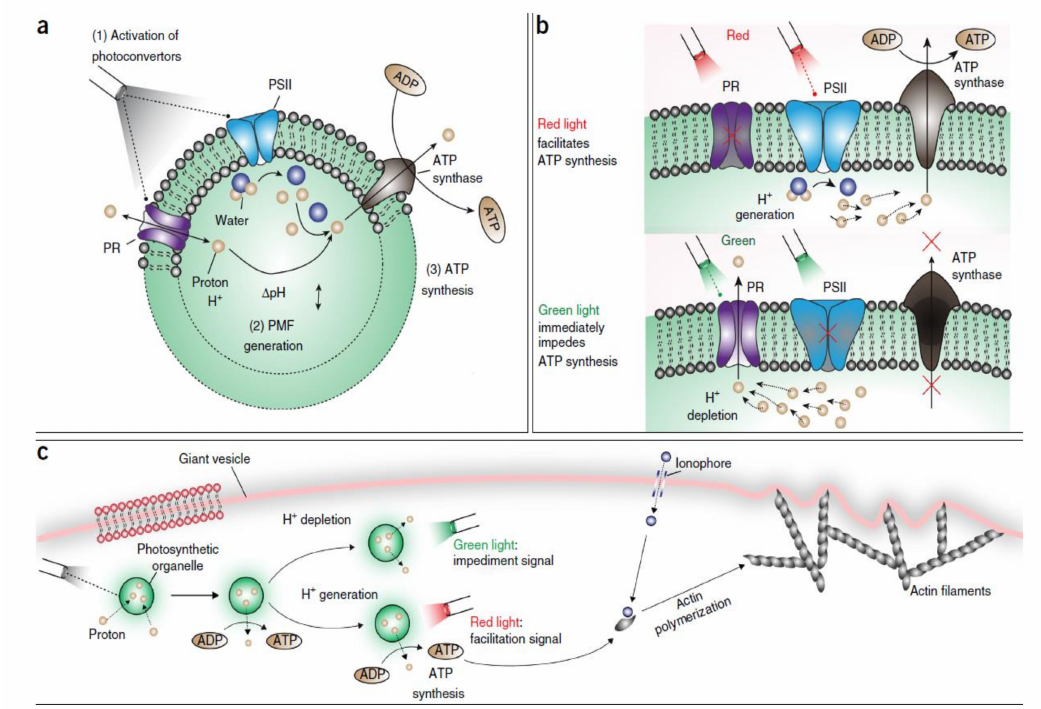
Figure 12. Artificial photosynthetic organelles and their application. ( a ) Via light activation, photosynthetic system II (PSII) and proteorhodopsin (PR) created a proton gradient and ATP was produced. ( b ) With the same photosynthetic organelle, ATP synthesis was controlled by an optical switch. Red light facilitated ATP synthesis whereas green light hindered its production. ( c ) Encapsulation of the photosynthetic organelle as energy module within a giant vesicle for the coupling of ATP synthesis with actin polymerization. Red light facilitated the actin filament growth and green light impeded its growth. Reprinted by permission from Springer Nature, K. Y. Lee, S.-J. Park, K. A. Lee, S.-H. Kim, H. Kim, Y. Meroz, L. Mahadevan, K.-H. Jung, T. K. Ahn, K. K. Parker and K. Shin, Photosynthetic artificial organelles sustain and control ATP-dependent reactions in a protocellular system, Nat Biotechnol, Copyright (2018)